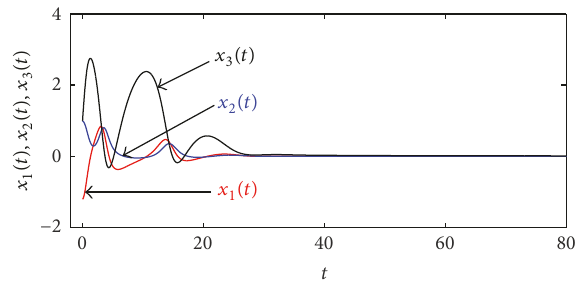
Figure 5: Stabilization of system (7) for 𝑞 = 0.98 and 𝐾 = −1 .